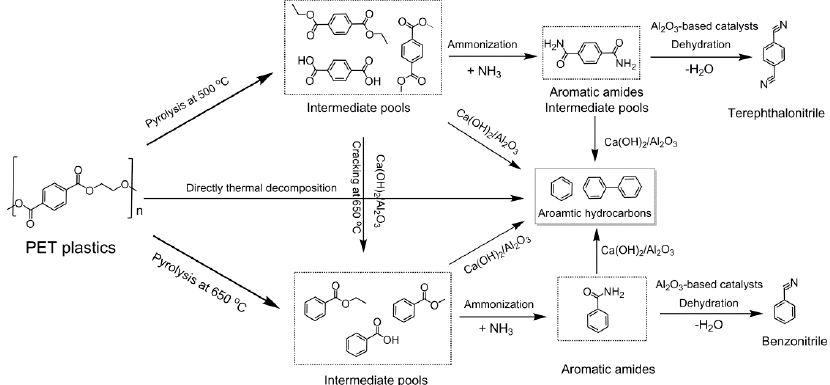
Figure 4. Possible reaction pathways from PET to terephthalonitrile and benzonitrile.